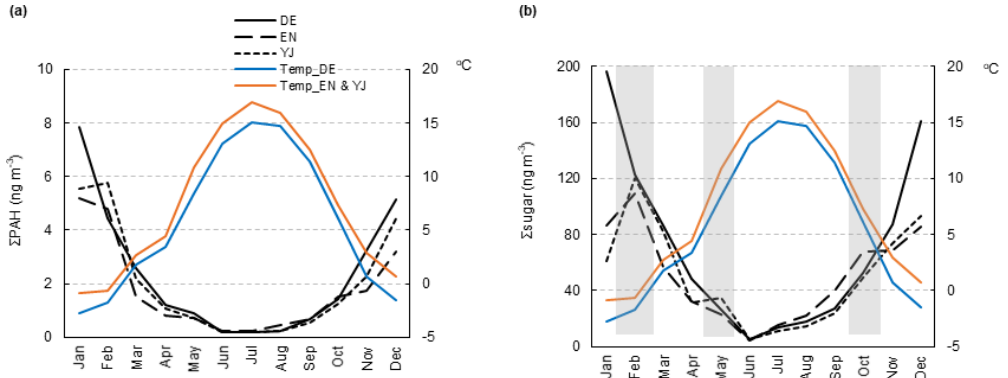
Figure 2. Seasonal variation of (a) (cid:54) PAHs (sum of 48 PAHs in Table S1) and (b) (cid:54) sugars (sum of levoglucosan, mannosan and galactosan) in PM 10 collected from three sampling sites (DE, EN and YJ) in 2017. The local temperature data were obtained from the Swedish Me- teorological and Hydrological Institute (https://www.smhi.se, last access: 26 July 2022). Periodic occasions with elevated sugar level were marked in grey colour in (b)